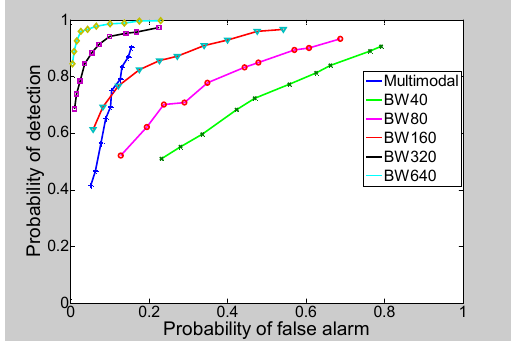
Figure 19. Receiver operating